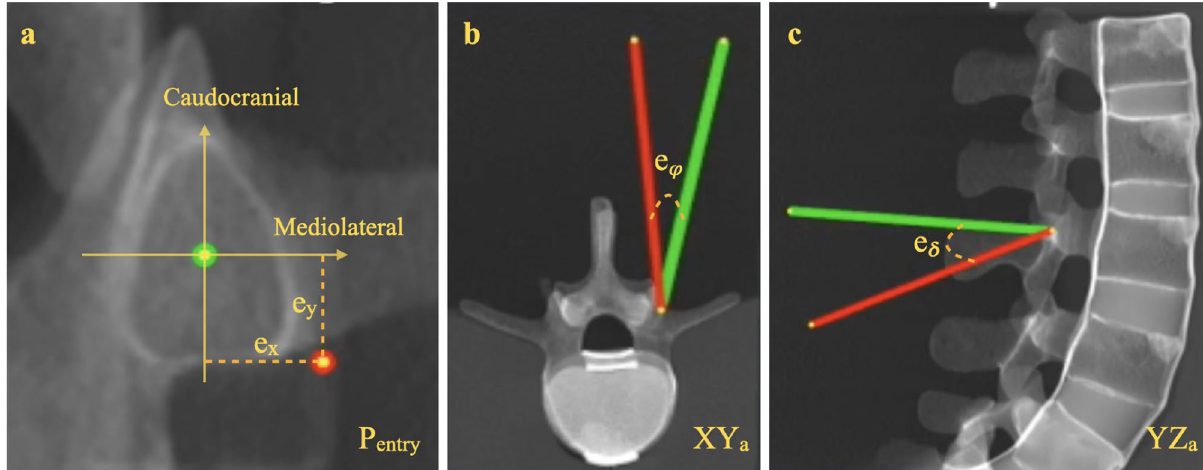
Figure 1. Three cross-sectional views of the CT from the spine phantom model, including the corresponding errors ( e x , e y , e φ , e δ ). The target and tool are visualized in green and red, respectively. ( a ) Corresponds to the coronal view visualizing, e x and e y projected on the P entry ; ( b ) represents the axial view visualizing e φ ; and ( c ) visualizes the sagittal view including e δ